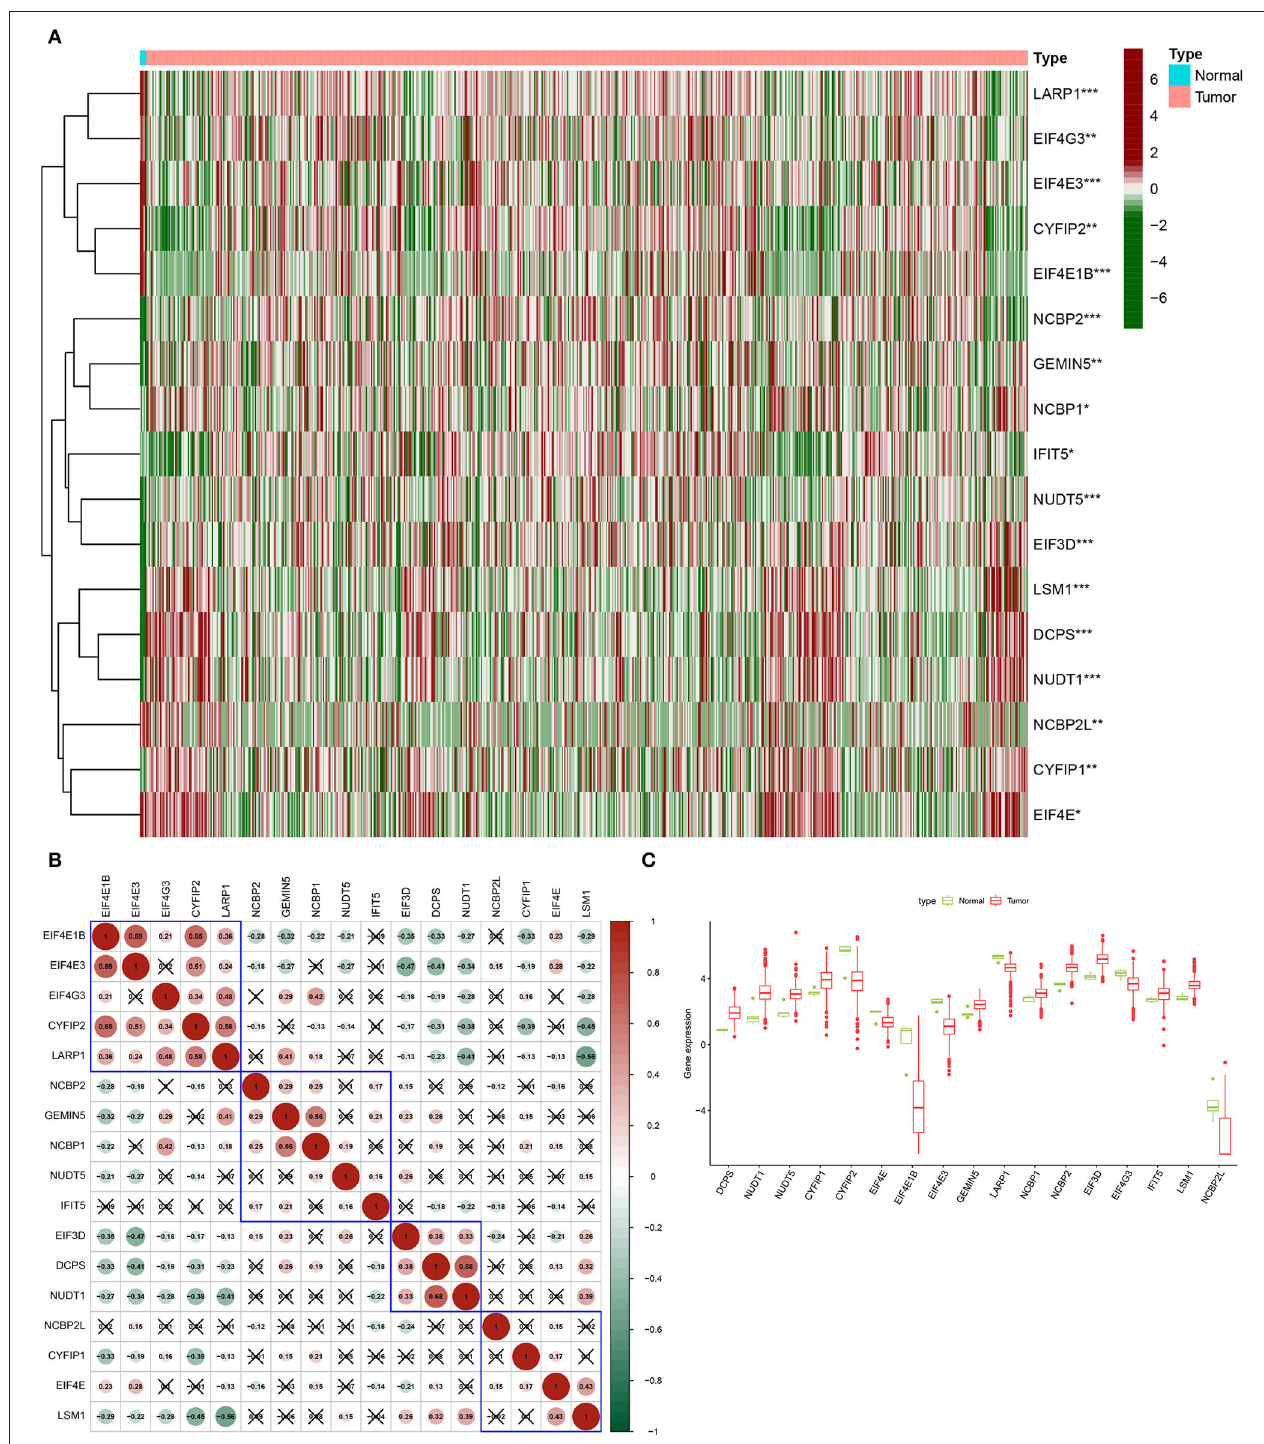
FIGURE 1 | Expression of m7G methylation regulators in glioma tissues and normal tissues. (A) Heat map showing 17 m7G RNA methylation regulators expressed at different levels between the two samples (Red for high expression level, green for low expression level. * p < 0.05, ** p < 0.01, *** p < 0.001). (B) Spearman correlation analysis of 17 m7G RNA methylation regulators in gliomas (Red for positive correlation, green for negative correlation). (C) Vioplot visualizes the expression levels of 17 m7G RNA methylation regulators in two samples.